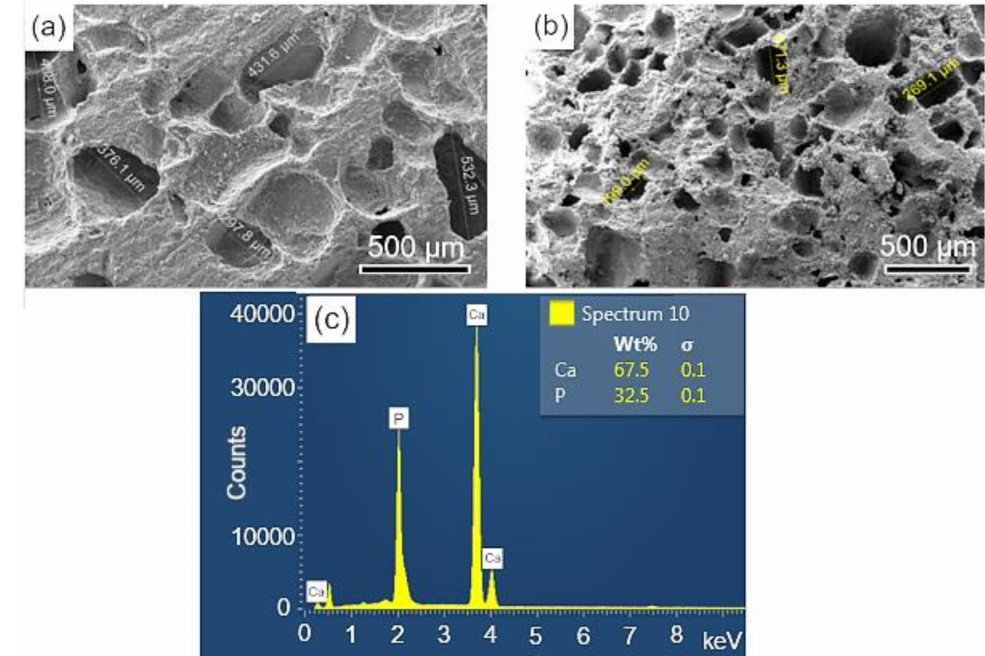
Figure 4. SEM of the scaffolds BCP sintered at 1100 ◦ C for 8 h: ( a ) surface (sanded with 400 grit sandpaper); ( b ) fracture; ( c ) semi-quantitative elemental analysis by EDS performed on the scaffold surface resulted in a molar ratio (Ca/P) of 1.6. Ca = calcium; P = phosphorus; %wt = mass fraction; σ = mean